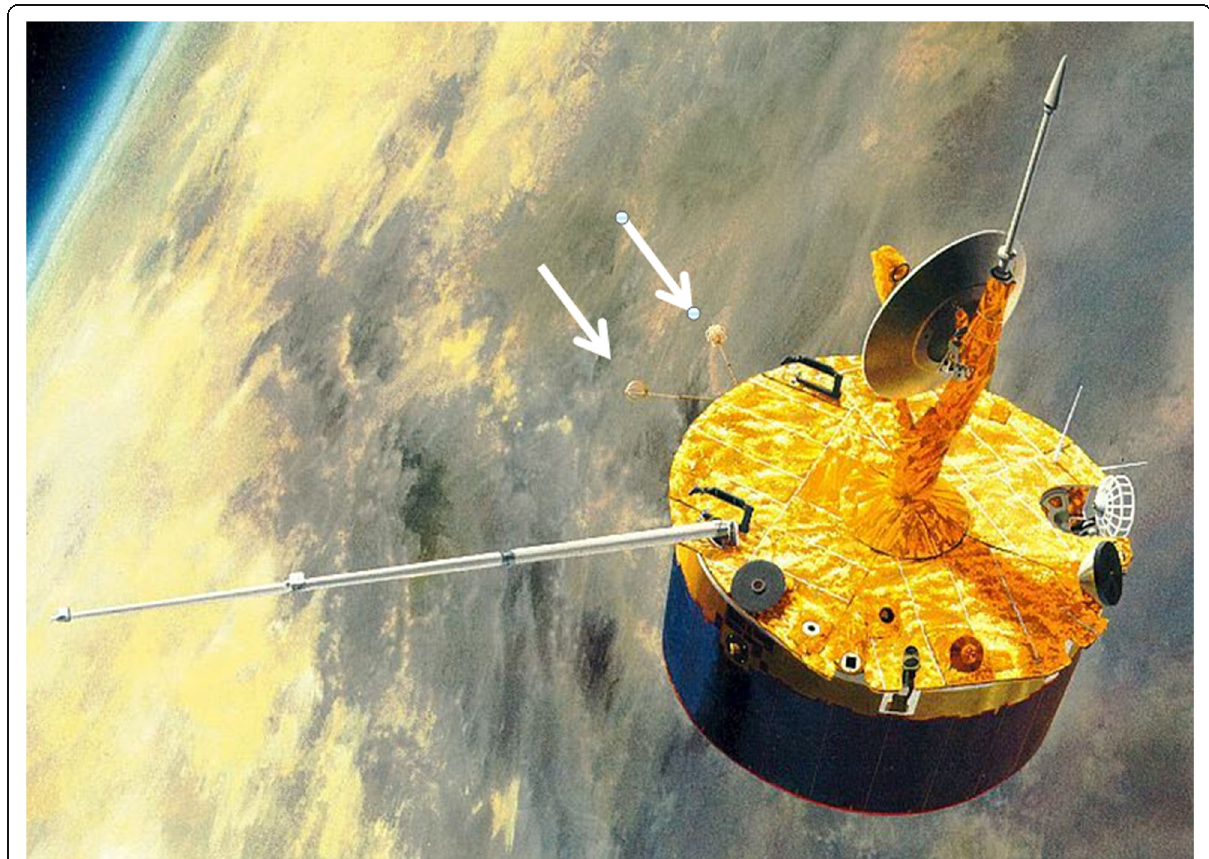
Fig. 9 NASA artists impression of the Pioneer Venus orbiter. The Orbiter Electric Field Detector (OEFD) measures the potential between two wire mesh sphere electrodes